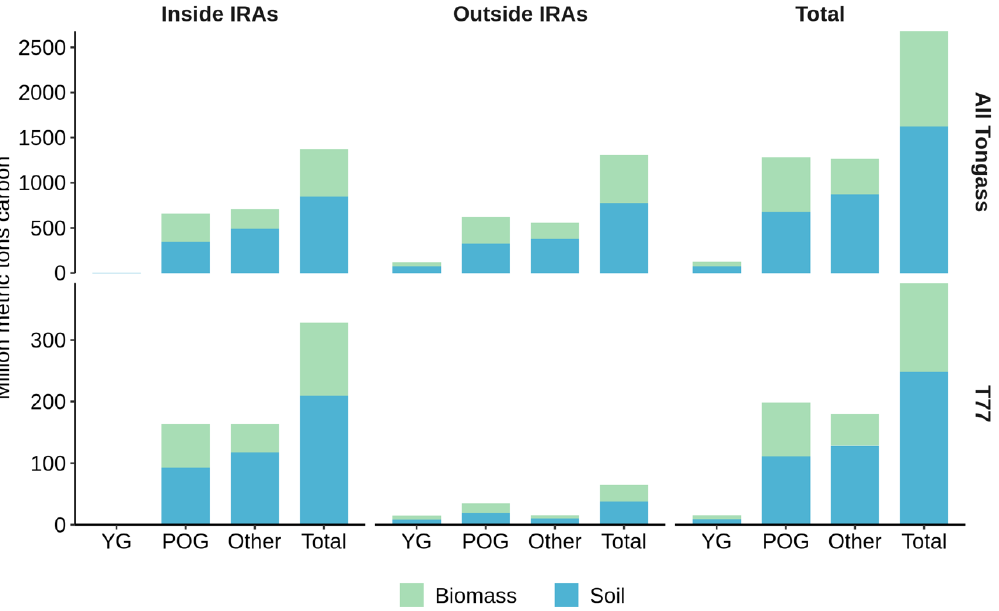
Figure 3. Carbon (million metric tons) stored in woody plant biomass and soil by forest age class (YG=young growth; POG=productive old growth) both inside and outside of Inventoried Roadless Areas (IRAs) and inside Tongass 77 watersheds (T77; bottom row) on the Tongass National Forest (top).